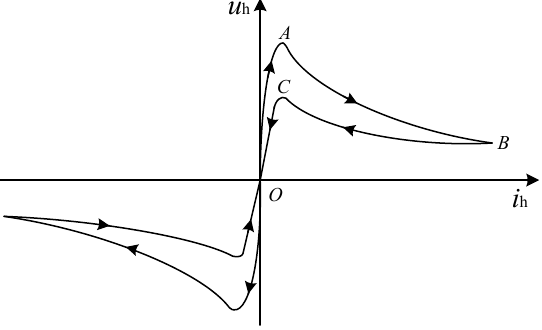
Figure 1. Volt–ampere characteristic curve of an AC arc.